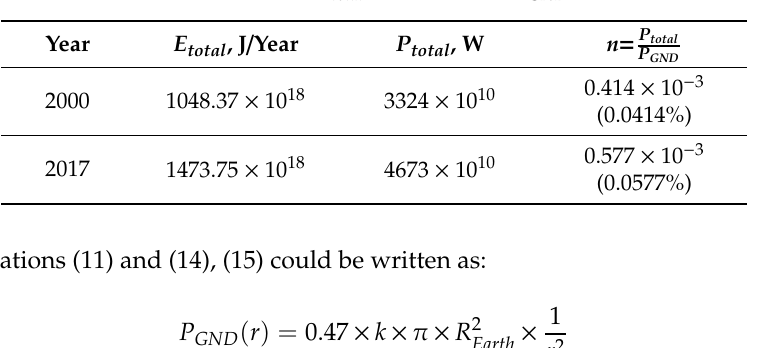
Table 1. Calculated values of P total and “ n ” ratio. P GND = 8.1 × 10 16